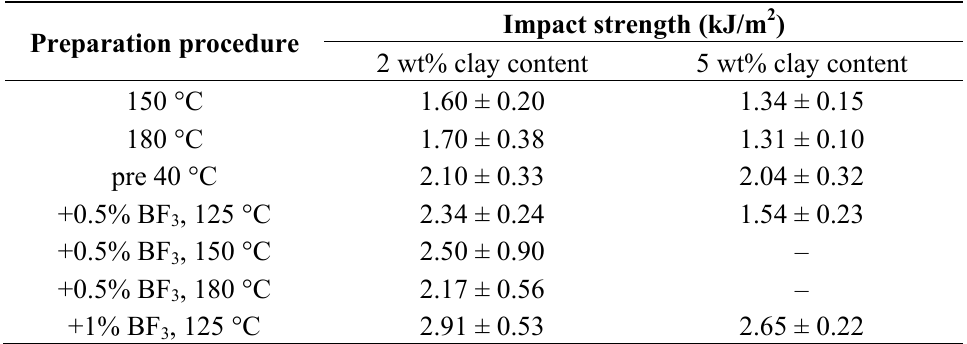
Table 2. Values of the impact strength for different TGAP/clay nanocomposites